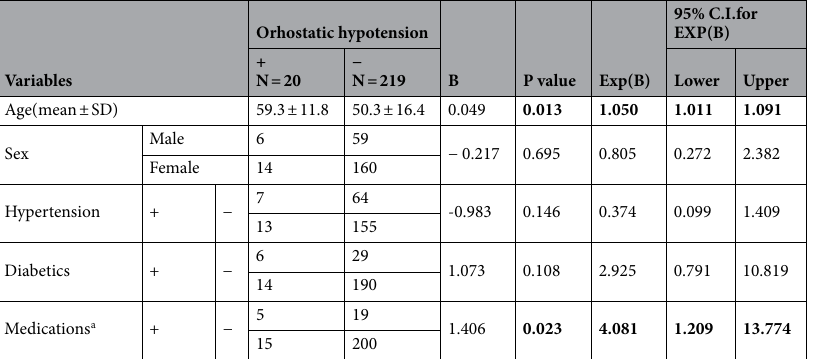
Table 1. Variables on orthostatic hypotension using binary logistic regression analysis. SD standard deviation, B unstandardized coefficient, Exp(B) the exponentiation of the B coefficient, CI confidence interval. a The diseases of the drug-taking were arrhythmia, heart disease, antidepressant, thyroid disease, hypnotic and prostate disease. Bold values indicate statistical significance (p < 0.05).